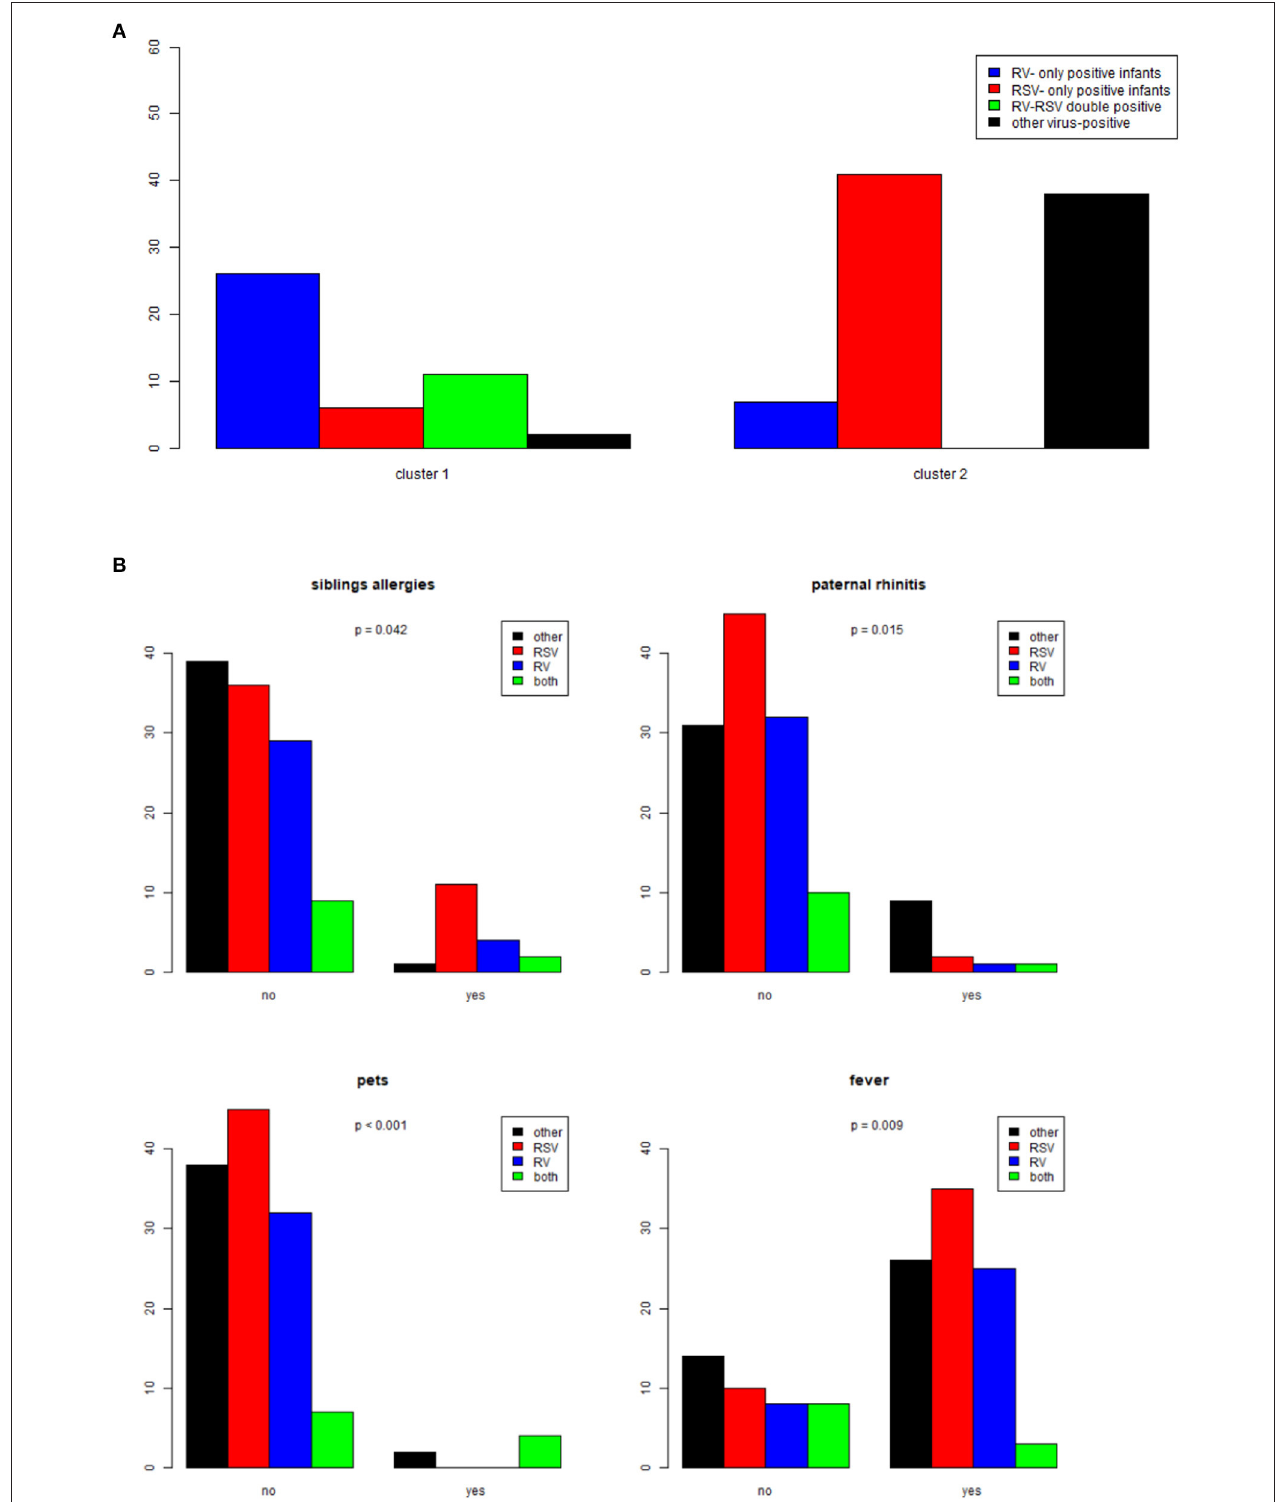
FIGURE 2 | (A) Association between respiratory viruses detected in nasopharyngeal washes (RV-only, RSV-only, RV-RSV double positive, other virus-positive) and Clusters 1 and 2. (B) Graph depicting significant correlations between demographic and clinical characteristics and viruses in nasopharyngeal washes (RV-only, RSV-only, RV-RSV double positive, other virus-positive).